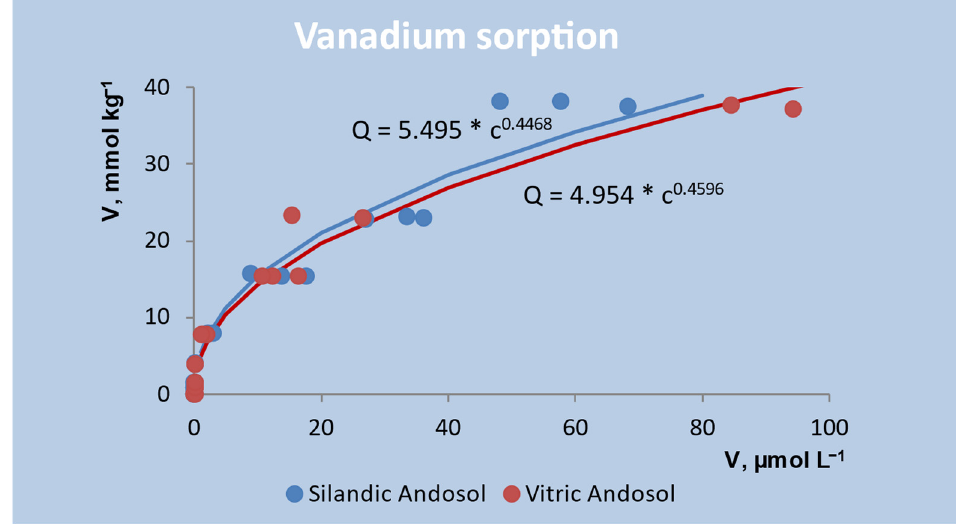
Figure 2. V sorption isotherms (sorbed V (mmol kg − 1 ) vs. V concentration in the equilibrium solution ( µ mol L − 1 )) fitted to the Freundlich model.